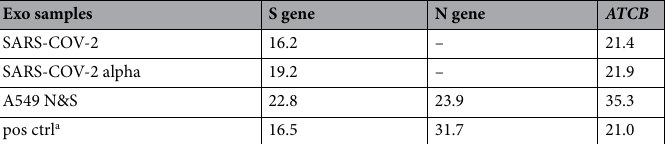
Exo samples S gene N